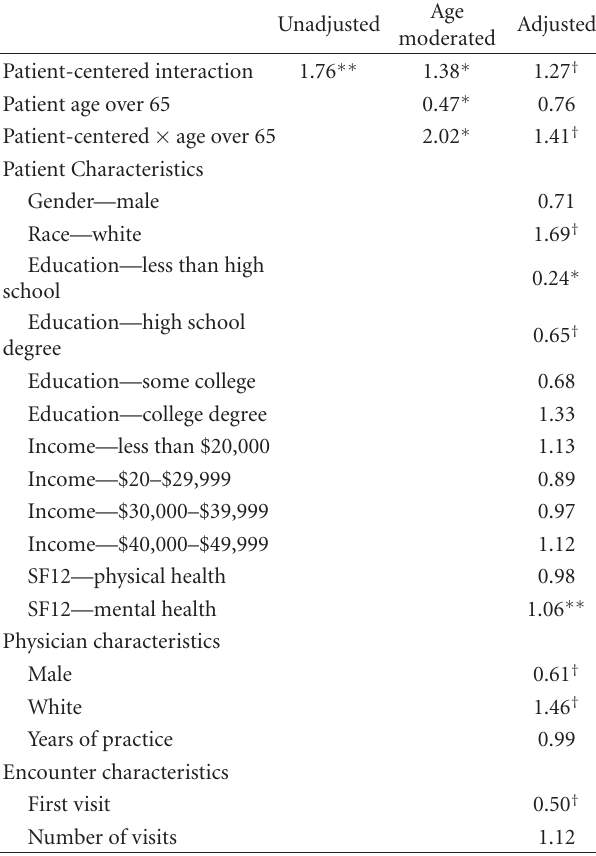
Table 6: Odds ratios from binary logistic regression predicting patient-centered interaction.